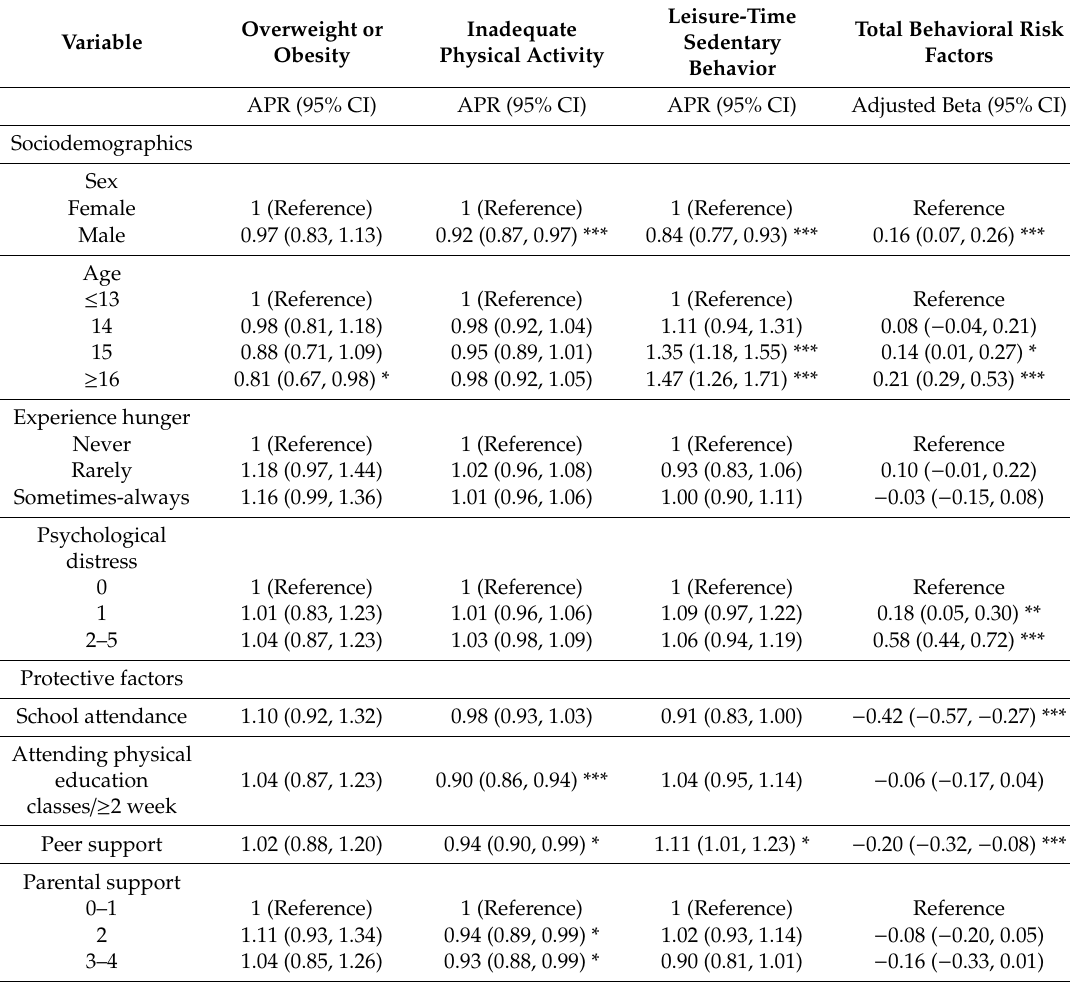
Table 3. Associations with behavioral NCD risk factors (overweight or obesity, physical inactivity, leisure-time sedentary behavior, and total number of behavioral NCD risk